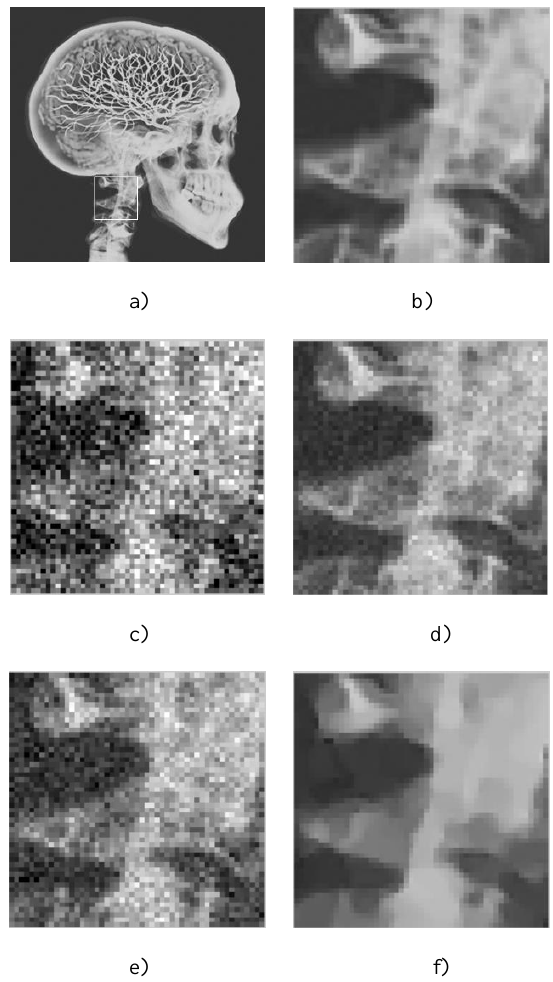
Table 2. Dependency of restoration result on initial